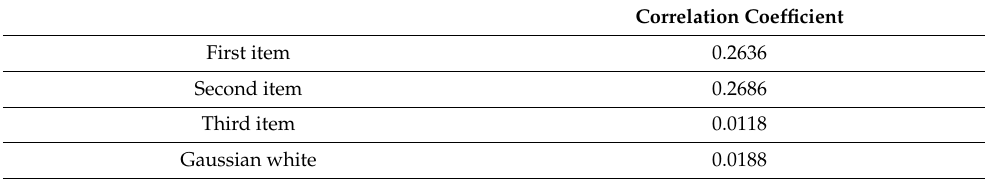
Table 2. Correlation